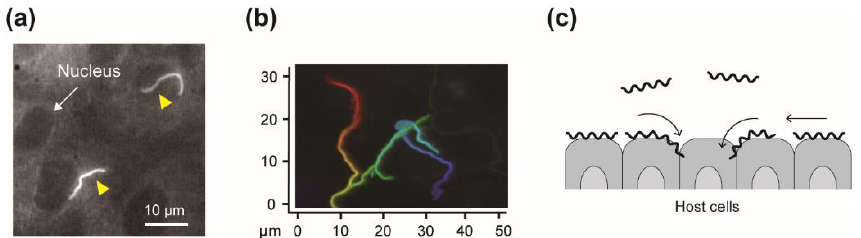
Figure 5. Crawling of Leptospira on the cultured kidney cells [38]: ( a ) Epi-fluorescence image of the L. interrogans serovar Icterohaemorrhagiae on the rat kidney cell line (NRK-52E). ( b ) A trajectory of a crawling L. interrogans ; time courses in the order of red, orange, yellow, green, blue, and indigo. ( c ) A hypothesis of crawling-dependent pathogenicity. This figure was made using some data re- ported in [38] with some modifications.